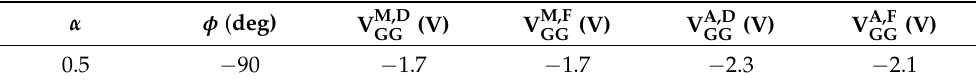
Table 1. Nominal values of the parameters considered for DIDPA